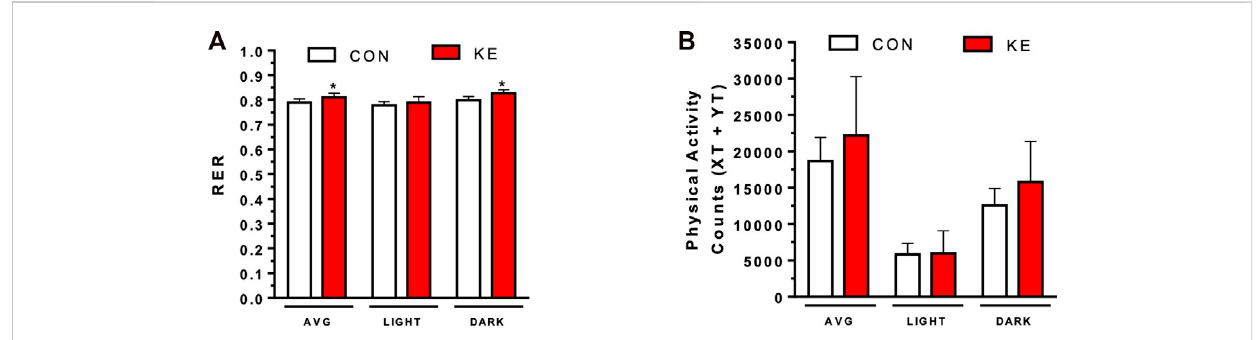
FIGURE 3 Finalrespiratoryexchange ratio(RER)andphysical activitycountsmeasurements. (A) RERwascalculatedas VCO 2 /VO 2 .P < 0.05, totalanddarkRER. (B) Physical activity counts were measured using XT and YT activity. Values are presented as means ± SD. p < 0.05, * indicates signi fi cant differences between